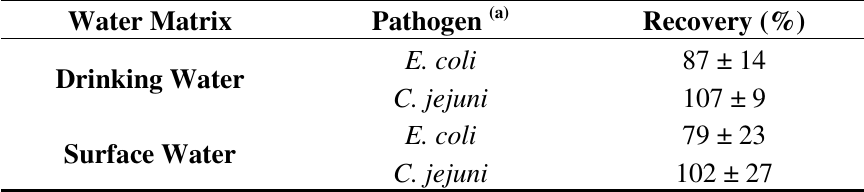
Table 2. Recovery of spiked bacteria from filtered